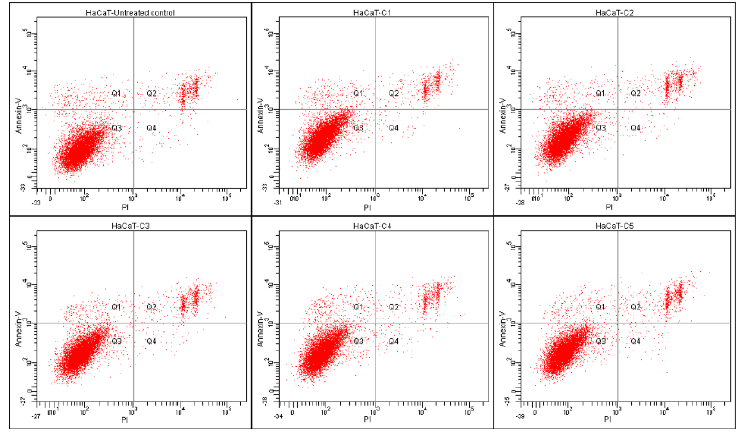
Figure 3. Apoptosis evaluation in HaCaT cells after treatment with the HM. After 24 h of treatment, cells were stained with annexin V-FITC (50 µg/mL) and propidium iodide (100 µg/mL) and were evaluated with a BD FACS Canto II flow cytometer (Becton Dickinson, USA), by using BD FACS Diva 6.1.2 software. The results are presented in scatter plots of annexin V-fluorescein isothiocyanate versus vital dye propidium iodide labelling Q3, viable cells; (annexin V- FITC (−), PI (−)) ; Q1, early apoptotic cells (annexin V-FITC (+), PI (−)) ; Q2, late apoptotic (annexin V-FITC (+), PI (+)); and Q4, necrotic cells (annexin V- FITC (−), PI (+)).